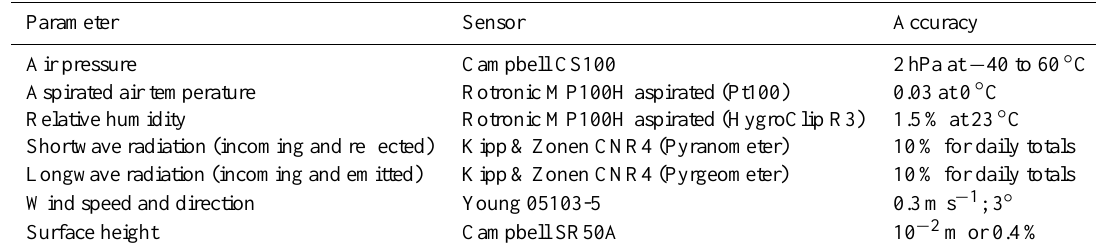
Table 1. Sensors and their published accuracies.